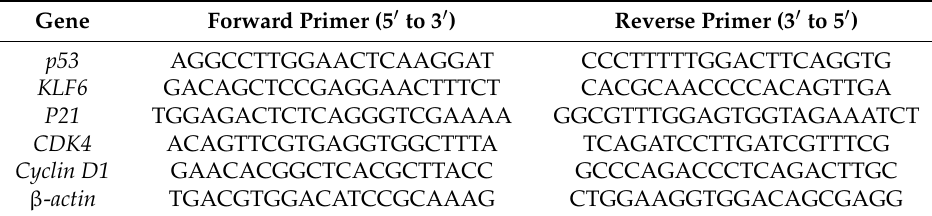
Table 1. Primer sequences used in quantitative real ‐ time PCR.